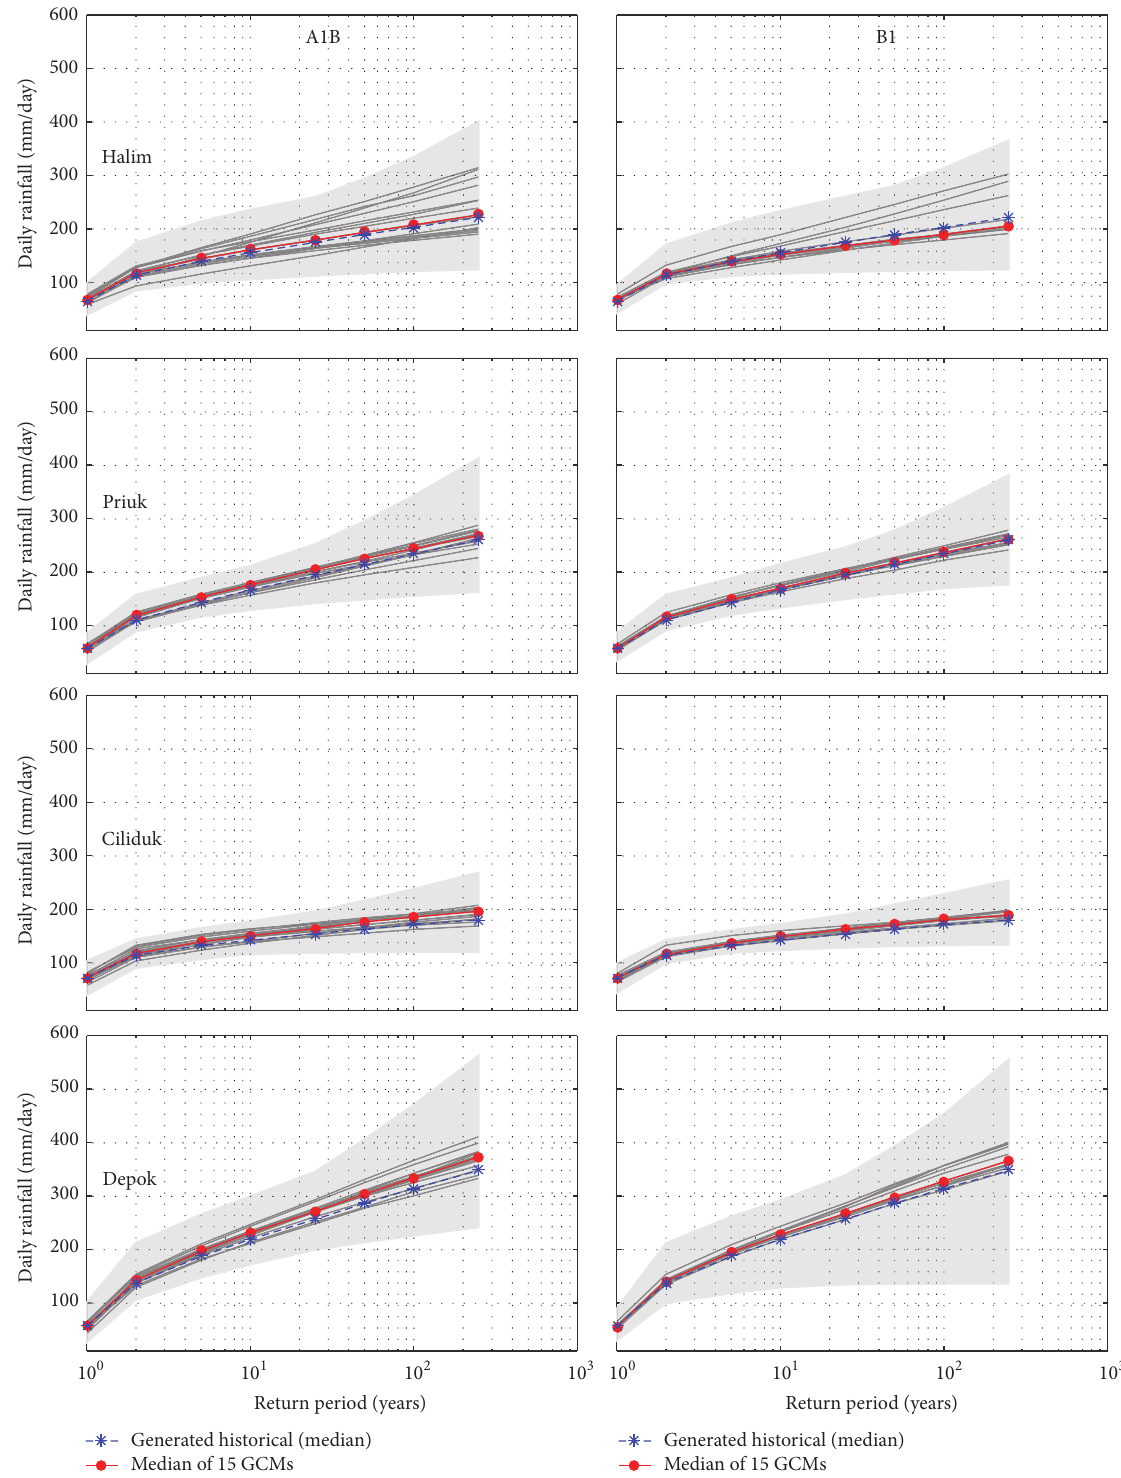
Figure 8: Daily RP curves comparison between GCM predictions from emission scenarios A1B and B1 for future (2046–2065) and historical generated rainfall with LARS-WG. The medians of 100 realizations for each of the 15GCMs are indicated with thick grey line and the grey shade represents all 15 × 100